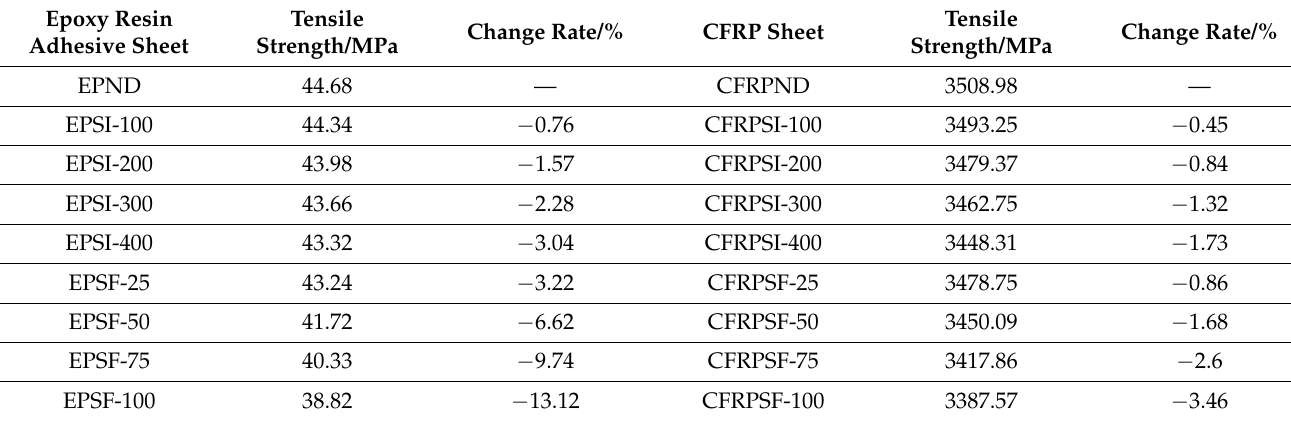
Table 5. Tensile strength of epoxy resin and CFRP sheet.